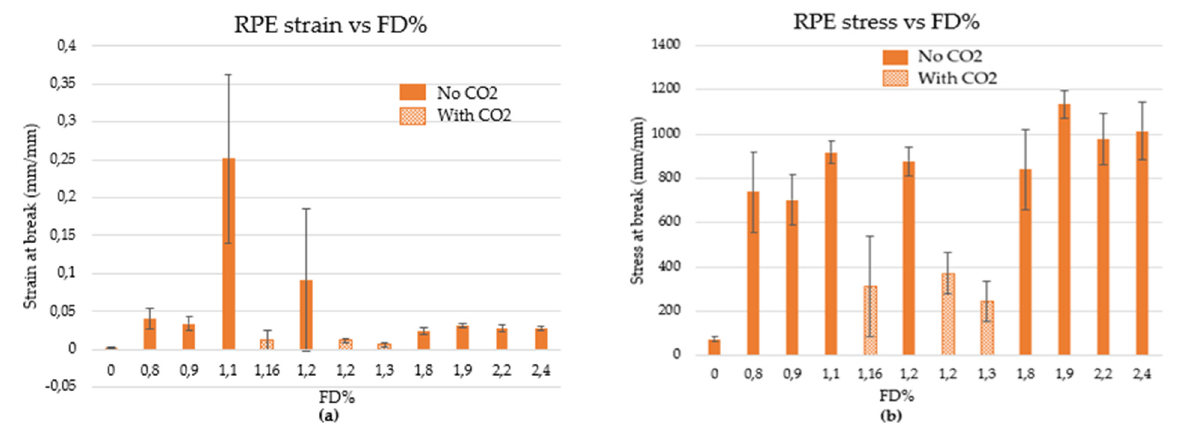
Figure 11. Strain ( a ) and stress ( b ) at break for grafted RPE samples with different FD.